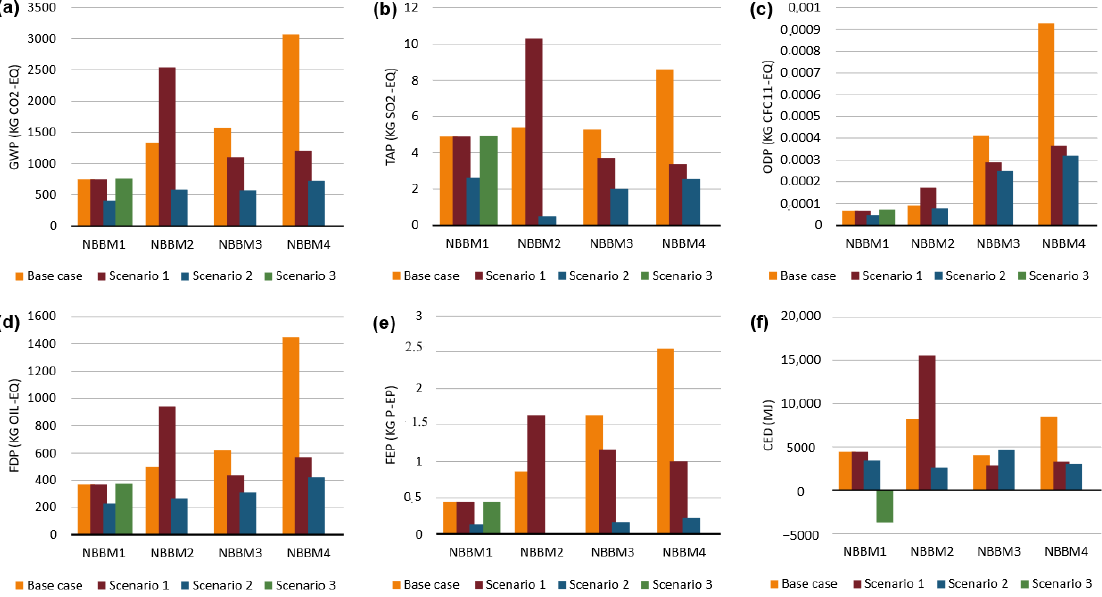
Figure 2. ( a ) Global warming potential, ( b ) terrestrial acidification potential, ( c ) ozone depletion potential, ( d ) fossil depletion potential, ( e ) freshwater eutrophication potential, and ( f ) cumulative energy demand of NBBMs in four scenarios.